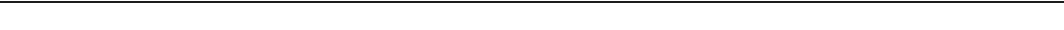
Fig. 5 CTCF-s activates IFI6 by disrupting CTCF-mediated looping and establishing distal enhancer − promoter contacts. a GO analysis of upregulated genes after CTCF-s gain-of-function. b Relative expression of interferon-signaling-associated genes after CTCF and CTCF-s gain-of-function, respectively (mean ± s.d., two-tailed Student ’ s t test; n = 3 biological replicates, each biological replicate had three technical replicates). c Growth curves of HeLa-S3 cells with gain-of-function of FLAG, FLAG-CTCF and FLAG-CTCF-s, respectively. Data were shown as mean ± s.d. from three independent experiments with the indicated signi fi cance by using a two-tailed Student ’ s t test. d Effects of CTCF and CTCF-s overexpression on apoptosis in HeLa-S3 cells after knocking- down endogenous CTCF and CTCF-s. Data were shown as mean ± s.d., n = 3 biological replicates. e Apoptosis analysis of HeLa-S3 cells overexpressing FLAG, FLAG-CTCF and FLAG-CTCF-s following IFI6 knocking-down and treatment with oxaliplatin for 24 h. Data were shown as mean ± s.d. from two independent biological replicates. f Hi-C interaction map at IFI6 locus. g Genomic view showing CTCF ChIP-seq and RNA-seq data from FLAG and